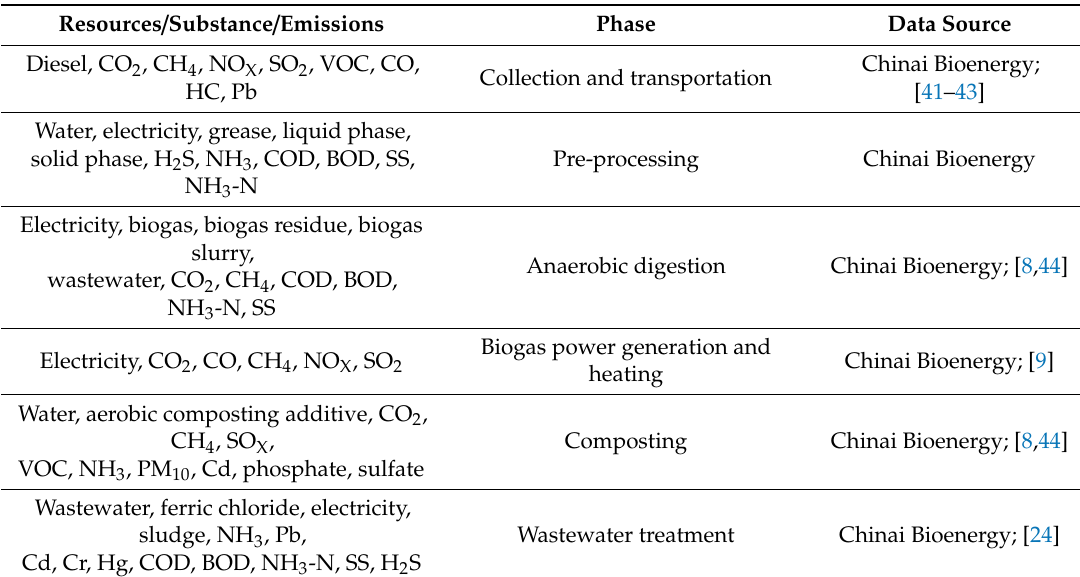
Table 1. Data sources related to the di ff erent phases.